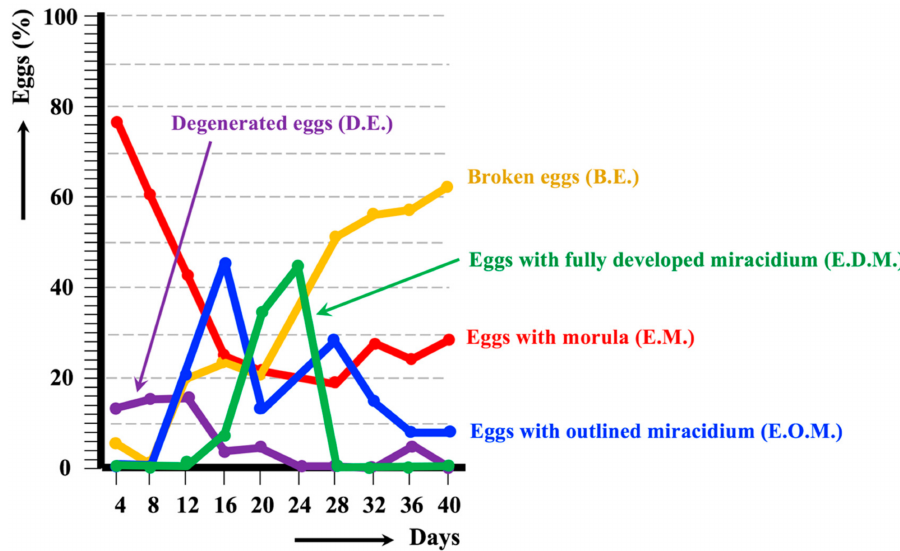
Figure 3. Graph showing the results of the experimental follow-up study of the egg embryonation of the isolate of Fasciola hepatica obtained from llama feces, and analyzed at 4-day intervals and constant temperature of 20 ◦